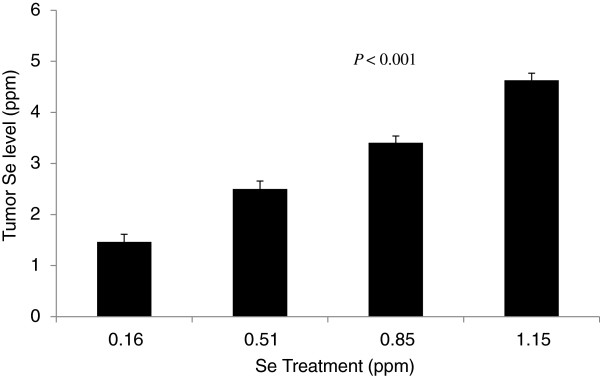
Tumor Se levels on a dry matter basis. MCF-7 tumors were excised from mice at day 70 of Se-casein treatment and subjected to Se analysis. Values are means ± SE for each treatment group (n = 11, 10, 14, and 13, respectively). The P-value represents the linear effect of dietary Se level.